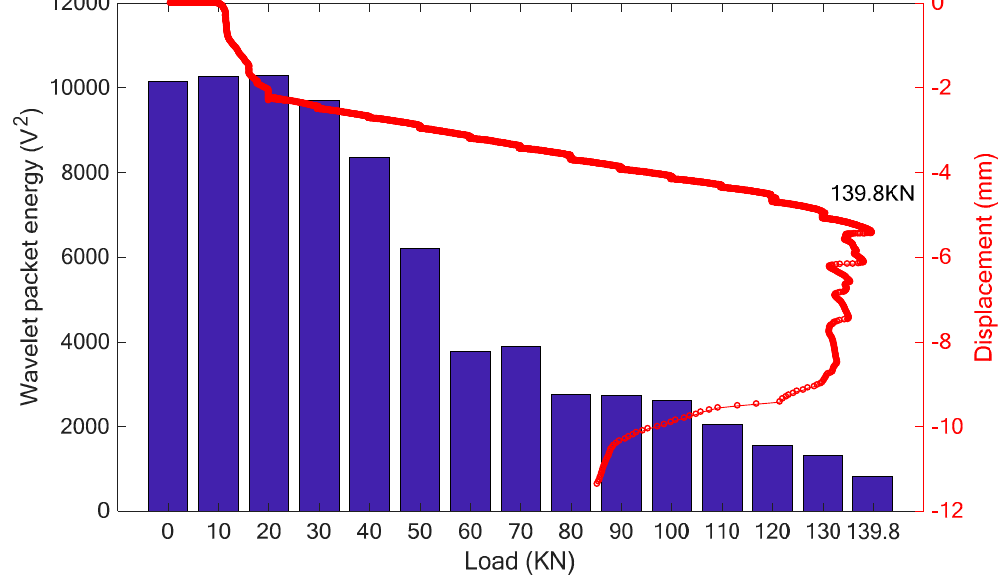
Figure 21. The result of wavelet packet energy.